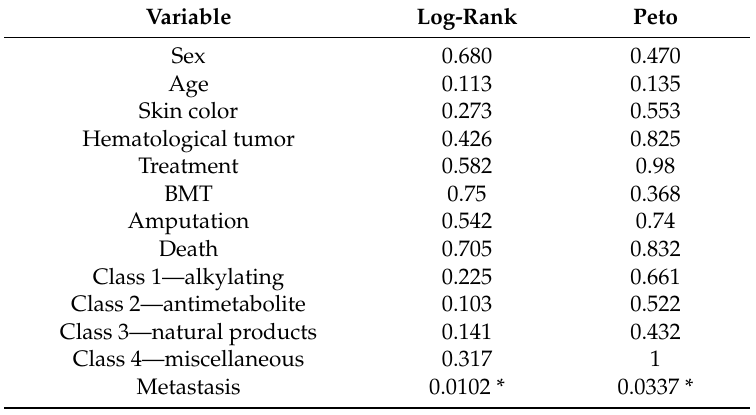
Table 2. Log-rank and Peto tests for the study variables of oncopediatric patients with severe